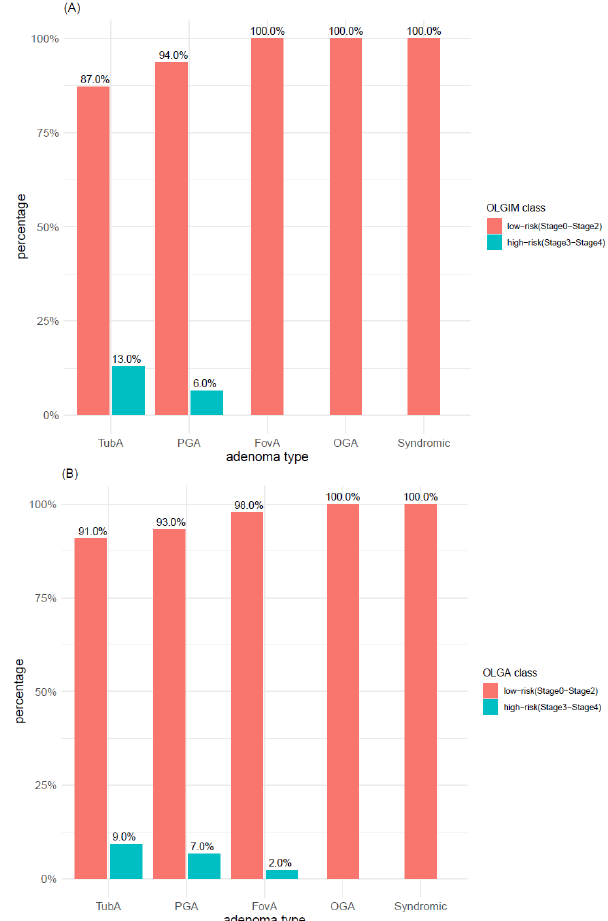
Figure 12. Distribution of ( A ) intestinal metaplasia and ( B ) atrophy within adenoma types according to OLGA and OLGIM classes (low-risk vs. high-risk). TubA: intestinal-type adenoma; PGA: pyloric gland adenoma; FovA: foveolar-type adenoma; OGA: oxyntic gland adenoma. The same analyses involving the distribution of OLGIM and OLGA classes were also performed to explore the differences between intestinal-type adenomas and gastric-type adenomas, the latter defined by grouping together FovA, PGA, and OGA cases. A significant association between gastritis types and OLGIM/OLGA classes was detected with a level of significance < 0.001. More specifically, a significantly higher proportion of IM and atrophy (OLGIM/OLGA stages >= 1) was found in intestinal tubular adenoma, whereas a higher number of OLGIM and OLGA stage 0 cases was found in gastric-type adenomas (Figure 13A,B). When analyzing the distribution of OLGIM and OLGA low-/high-risk classes within intestinal-type and gastric-type adenomas, the differences between the adenoma-types previously detected (Figure 13) seemed to be lost. Indeed, almost all cases belonged to the low-risk group (Figure